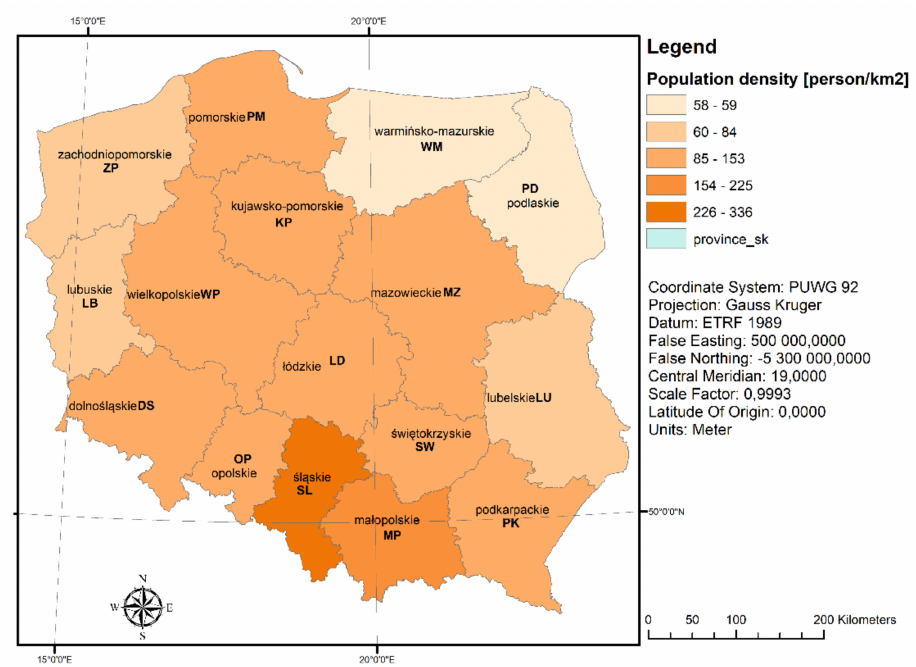
Figure 1. The research procedure.